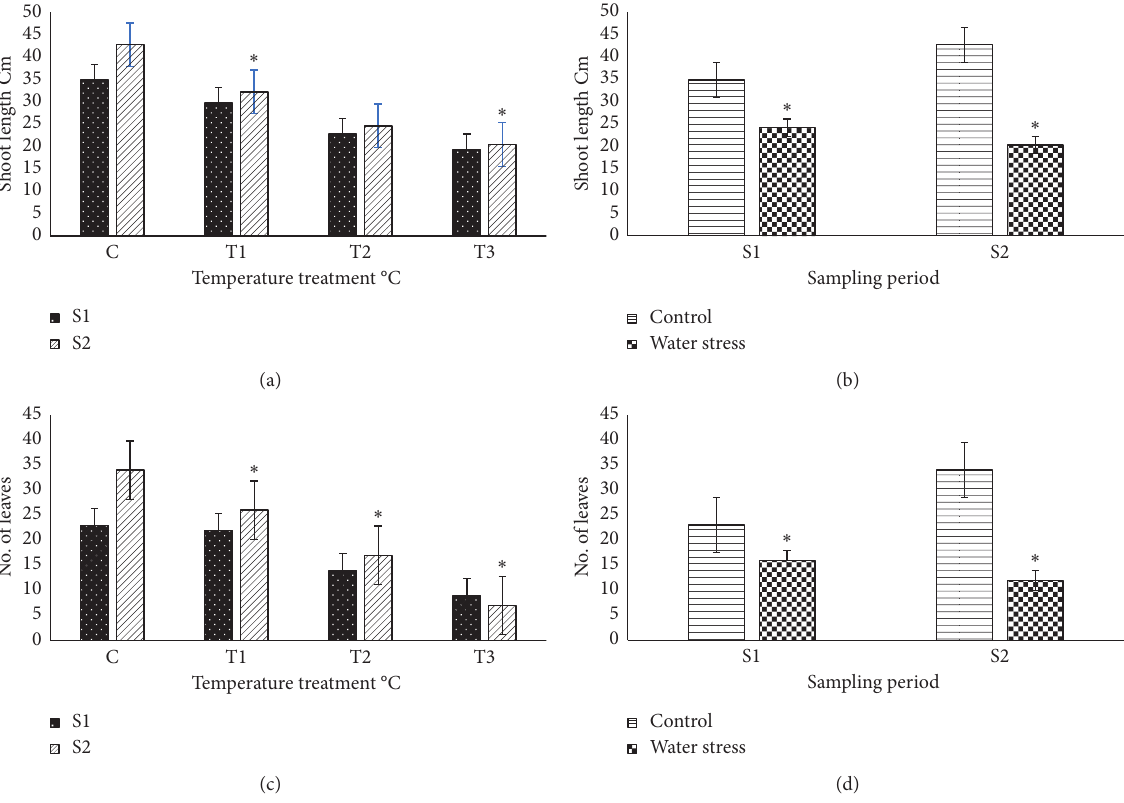
Figure 2: Effect of different climate temperatures (C, 25 ° C; T length (a, b) and number of leaves (c, d) after two sampling periods (S1, 14 days and S2, 21 days) in basil plants (mean ± SD, n � 10). Asterisks indicate significant differences between sampling periods of each treatment and differences between treatments for the same sampling period according to the Tukey test ( α �